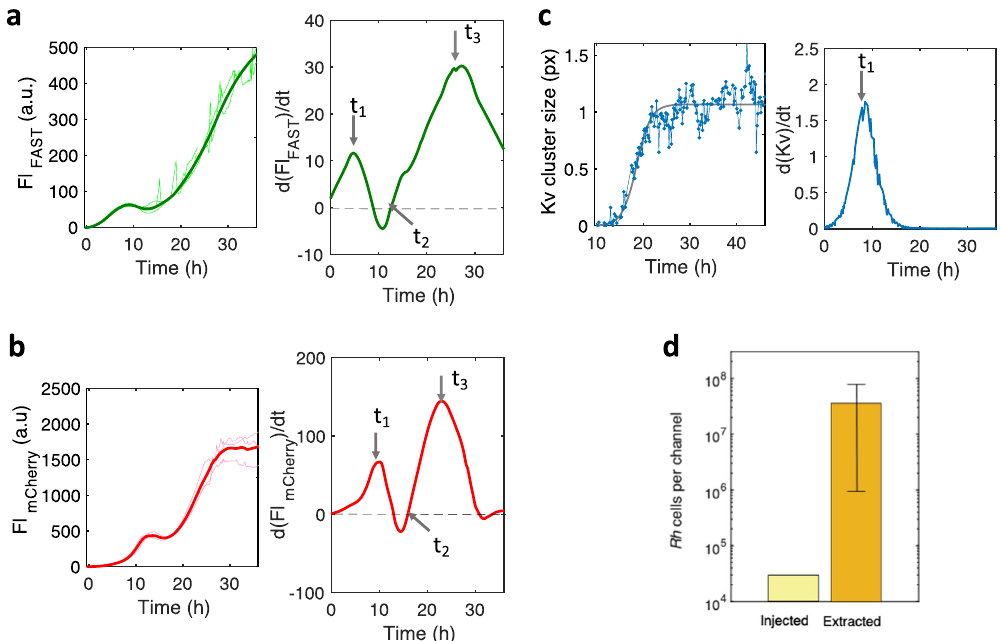
Fig. 3 Individual species developments in the 4S adherent community. a , b Kinetics of the fl uorescence intensity, Fl, from Bt -FAST (panel A, left side) and Pf -mCherry ( b , left side) in the 4S bio fi lm with the corresponding Fl curve derivative ( a , b , right side). Fl is the intensity per pixel averaged over the whole image. The arrows on the derivative curves mark the characteristic times t 1 , t 2 , and t 3 reported in Table 1. c Kv area detected on transmitted light images as a function of time (left panel, blue line) and corresponding logistic adjustment (gray line) together with its derivative (right panel) (details provided in Supplementary Fig. 9). a , b , c The signals were collected from 0.15 µm 2 images located as in Fig. 1a (black frame). Light curves are from three independent experiments, and the bold curve is the smoothed average. d Bar graph of Rh cells injected into the channel (light yellow bar) and recovered after 36 h of growth (dark yellow bar). The same experimental conditions were used as in Fig. 1. Error bar represents standard deviation.